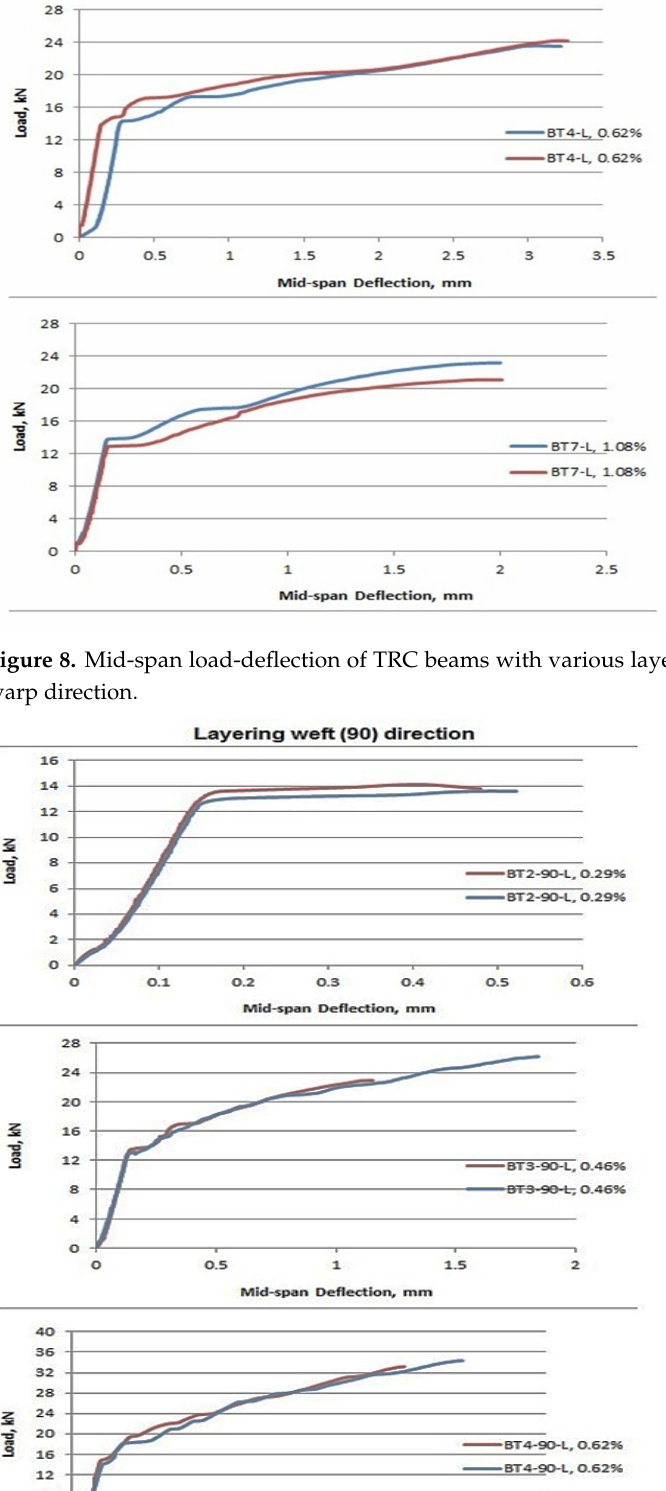
Figure 9. Mid-span load-deflection of TRC beams with various layers of woven fabric (2.5 cm) at the weft direction.